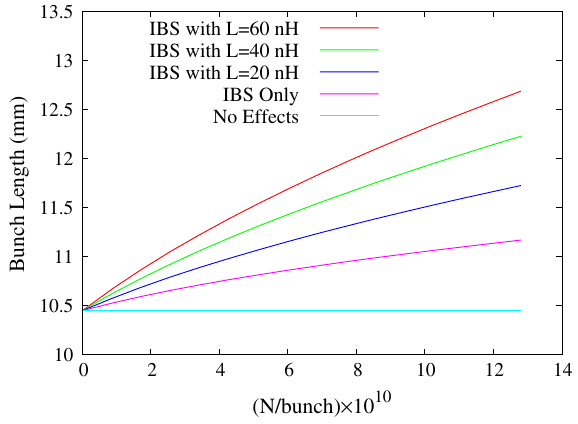
FIG. 4. Simulated effect on bunch length of PWD in combi- nation with IBS.